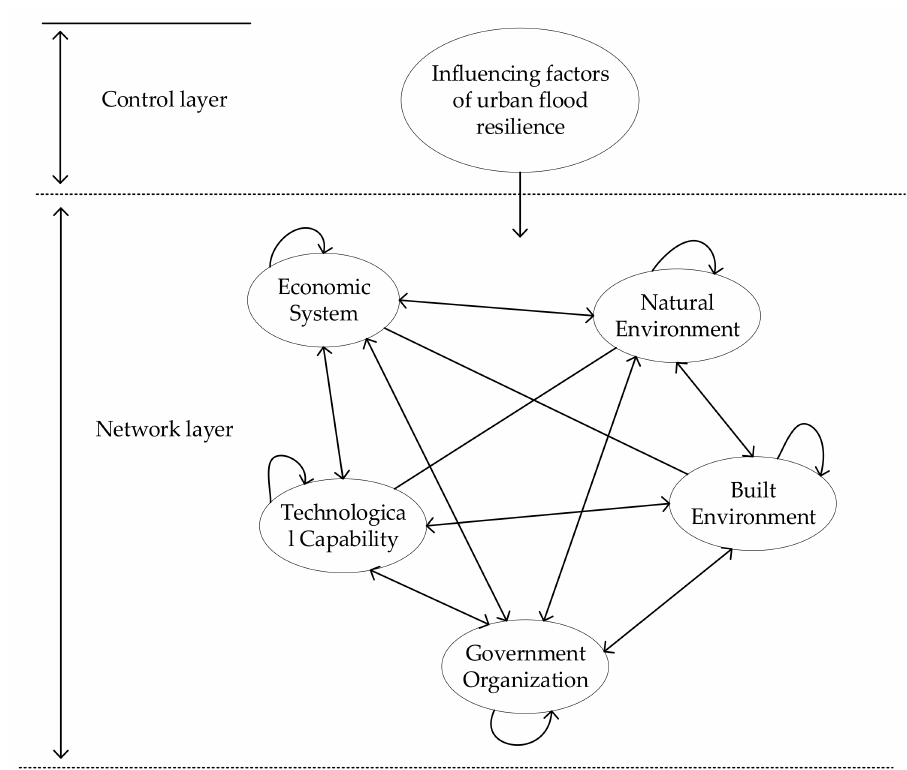
Figure 5. Hierarchical structure of urban flood